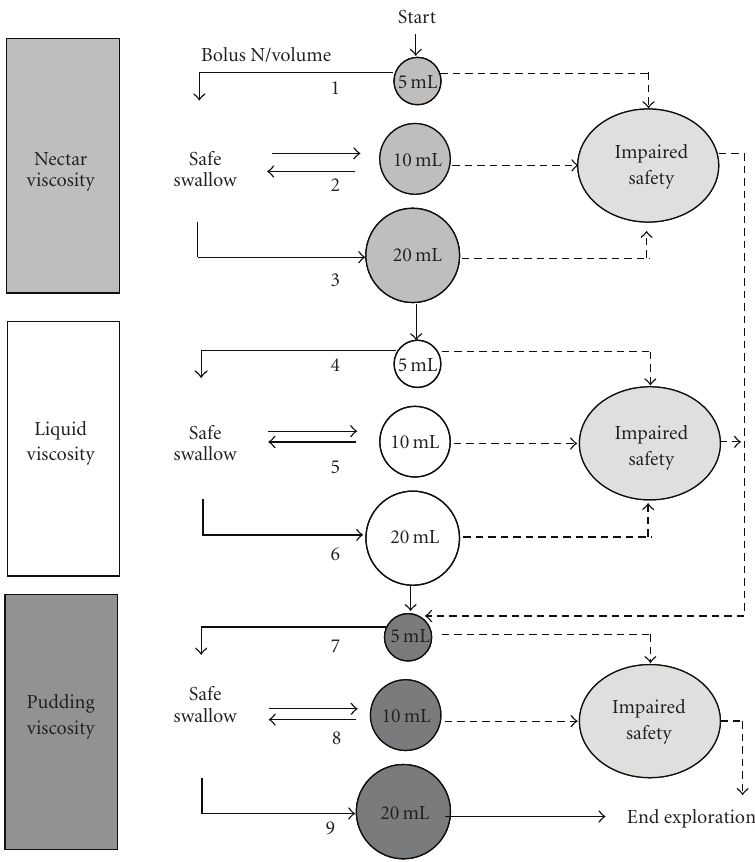
Figure 3: Algorithms of bolus volume and viscosity administration during V-VST. The strategy of the V-VST aims at protecting patients from aspiration by starting with nectar viscosity and volumes were increased from 5mL, to 10mL and 20mL boluses in a progression of increasing di ffi culty. When patients completed the nectar series without major symptoms of aspiration (cough and/or fall in oxygen saturation ≥ 3%), a less “safe” liquid viscosity series was assessed also with boluses of increasing di ffi culty (5mL to 20mL). Finally, a more “safe” pudding viscosity series (5mL to 20mL) was assessed using similar rules. If the patient presents a sign of impaired safety at nectar viscosity, the series is interrupted, the liquid series is omitted, and a more safe pudding viscosity series is assessed. If the patient presents a sign of impaired safety at liquid viscosity, the liquid series is interrupted and the pudding series is assessed (Figure